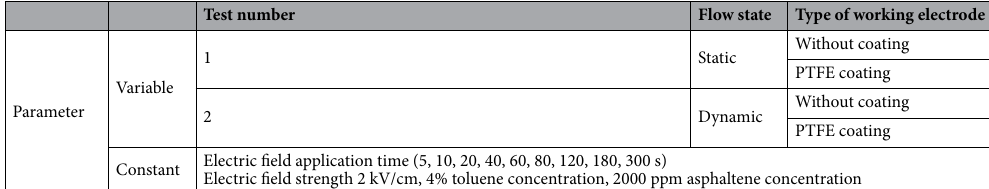
Test number Flow state Type of working electrode Variable Parameter